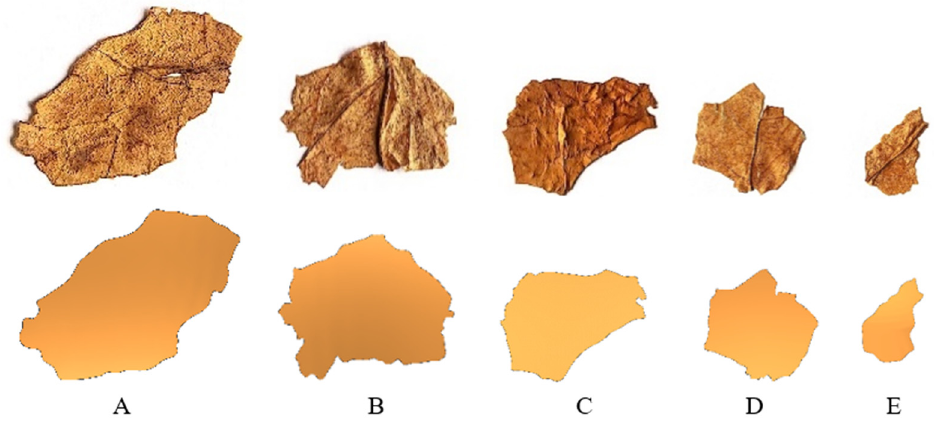
Figure 1. Real tobacco strips and corresponding models.